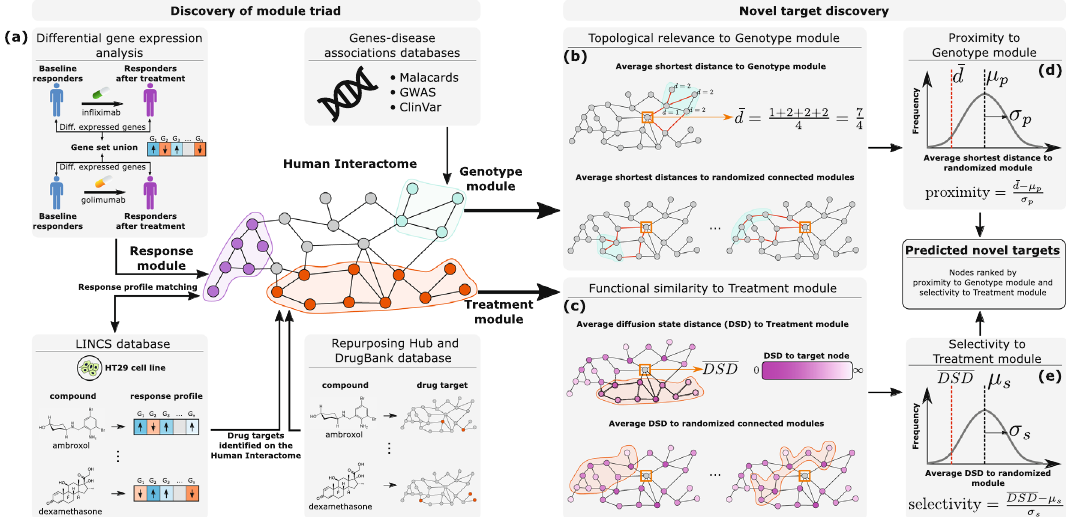
Figure 2. Overview of the module triad framework. (a) The pipeline for discovery of the UC module triad on the Human Interactome: the Response module is derived from differentially expressed genes before and after treatment in the patients with active UC who responded to TNFi therapies (infliximab and golimumab); the Genotype module is derived by mapping the genes associated with UC on the Human Interactome; the Treatment module is derived by selecting the small molecule compounds resulting in the alteration of gene expression of the Response module genes using experimental data in the HT29 cell line and mapping the compounds to their protein targets. Target prioritization based on the discovered module triad: (b),(d) topological relevance of a node to the Genotype module is measured by computing the average shortest path length of the node to all Genotype module nodes, and comparing it to the empirical distribution of average shortest path lengths to the randomized connected subnetworks of the same size as the Genotype module using Z -score (proximity); (c),(e) functional similarity of a node to the Treatment module is measured by computing the average diffusion state distance (DSD) of the node to all Treatment module nodes, and comparing it to the empirical distribution of average DSDs to the randomized connected subnetworks of the same size as the Treatment module using Z -score (selectivity). All nodes are ranked based on proximity and selectivity, and their ranks are combined using rank product to obtain the final target